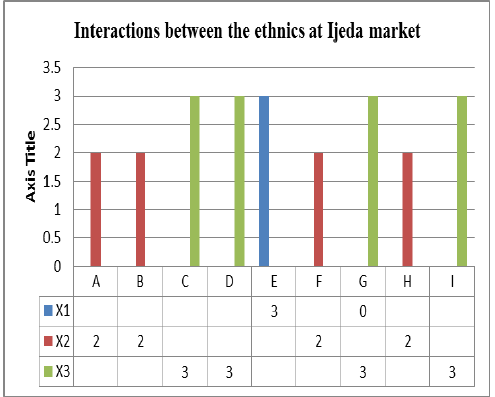
Figure 7. Residents’ interaction and duration in Ijeda market place . A =Hausa & Igbo , B =Hausa & Yoruba, C =Hausa & Hausa, D =Yoruba & Igbo, E =Yoruba & Hausa, F =Yoruba & Yoruba, G =Igbo & Hausa, H =Igbo & Yoruba, I =Igbo & Igbo.